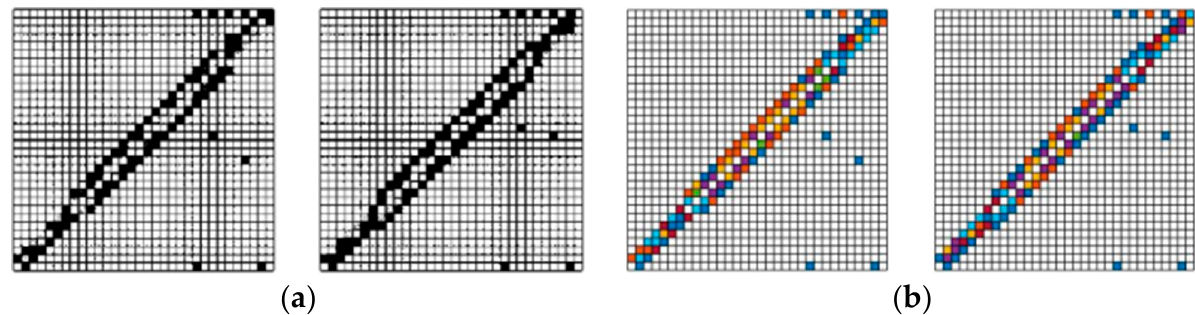
Figure 4. ( a ) Binary diagram of co ff ee machine and ke tt le. ( b ) Matrix heat map of co ff ee machine and ke tt le.